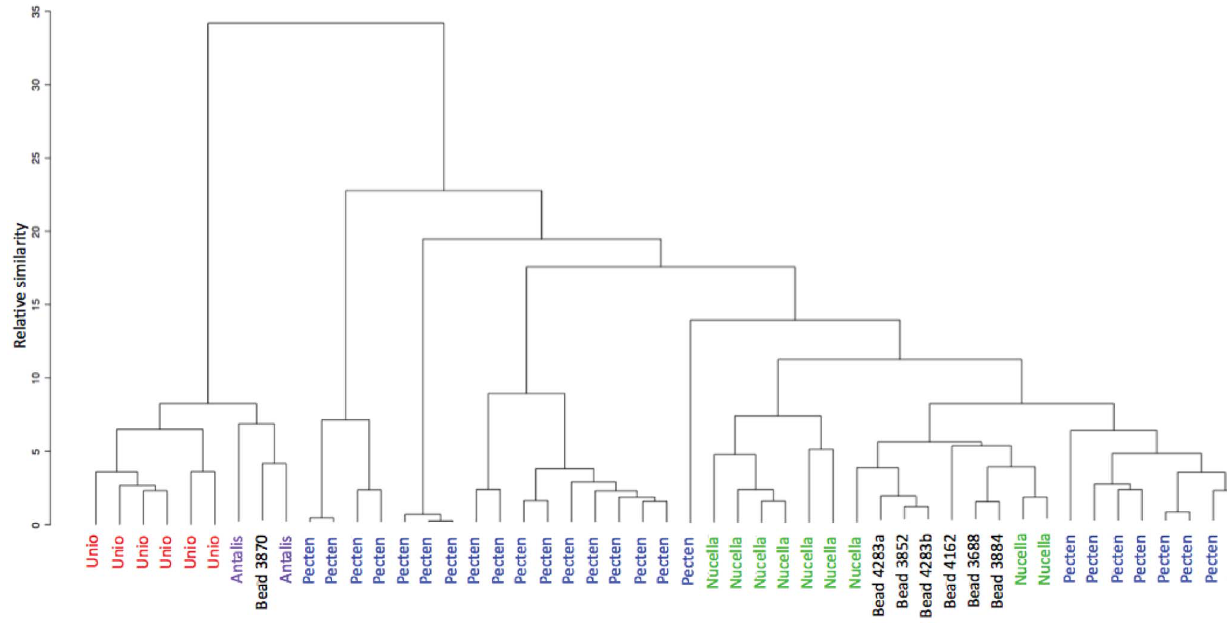
Figure 8. Dendogram for the genera most similar to the beads. Dendogram showing the results of hierarchical cluster analysis on the amino acid signatures for the genera most similar to the Great Cornard